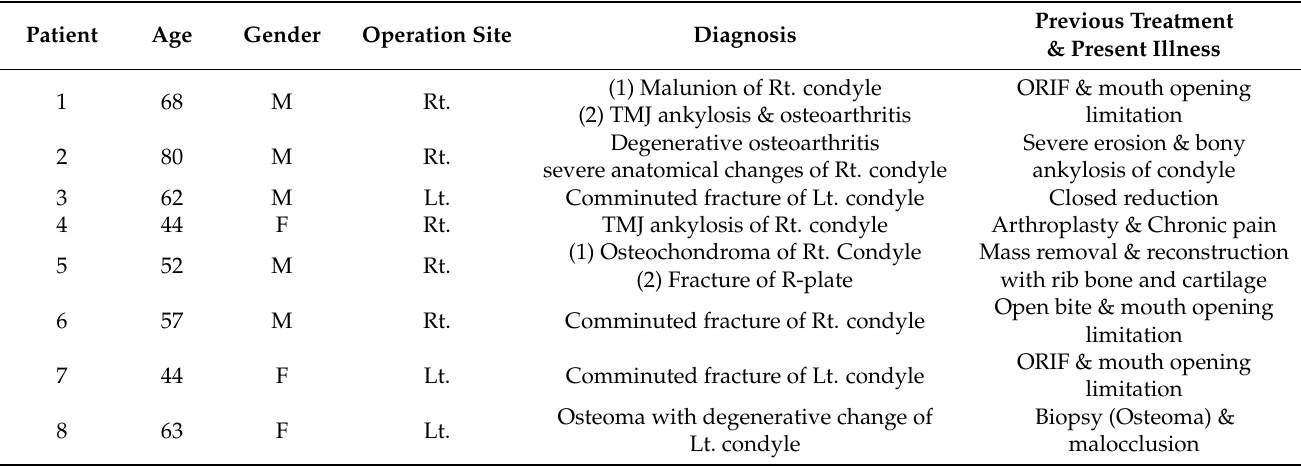
Table 1. Patient characteristics and diagnosis.